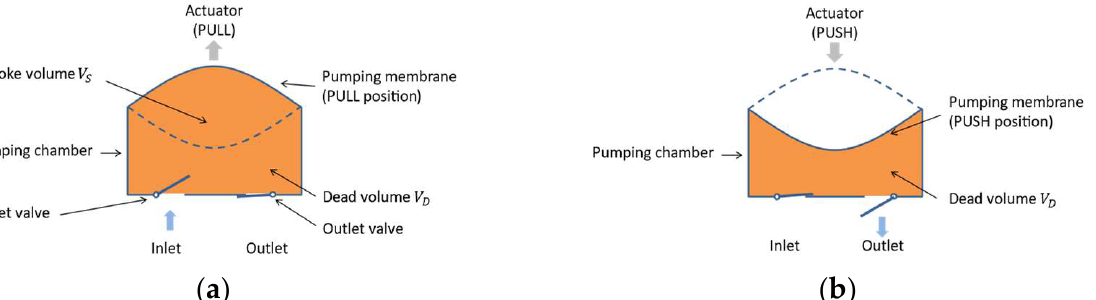
Figure 3. Schematics of a membrane micropump with passive check valves during ( a ) the supply phase and ( b ) the infusion phase.